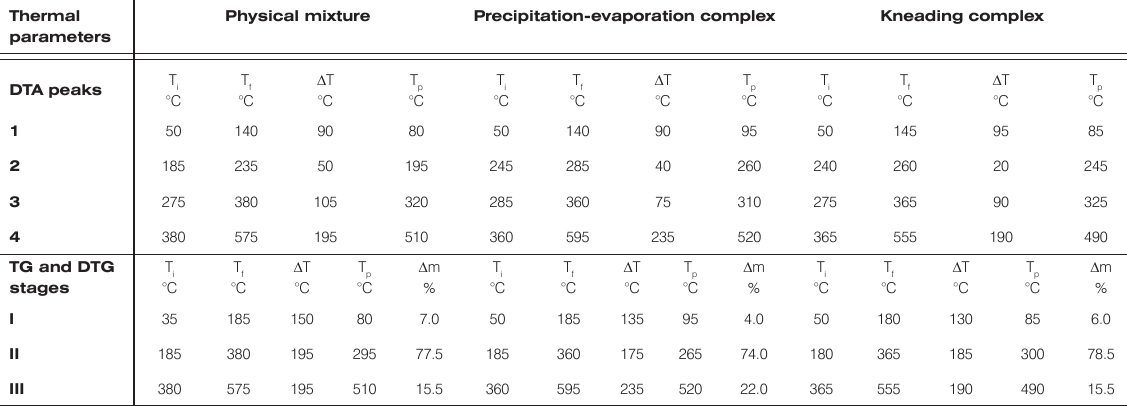
Table 3. DTA, TG and DTG data sets for physical mixture and inclusion complexes of salicylamide with 2-hydroxypropyl- β -cyclodextrin.